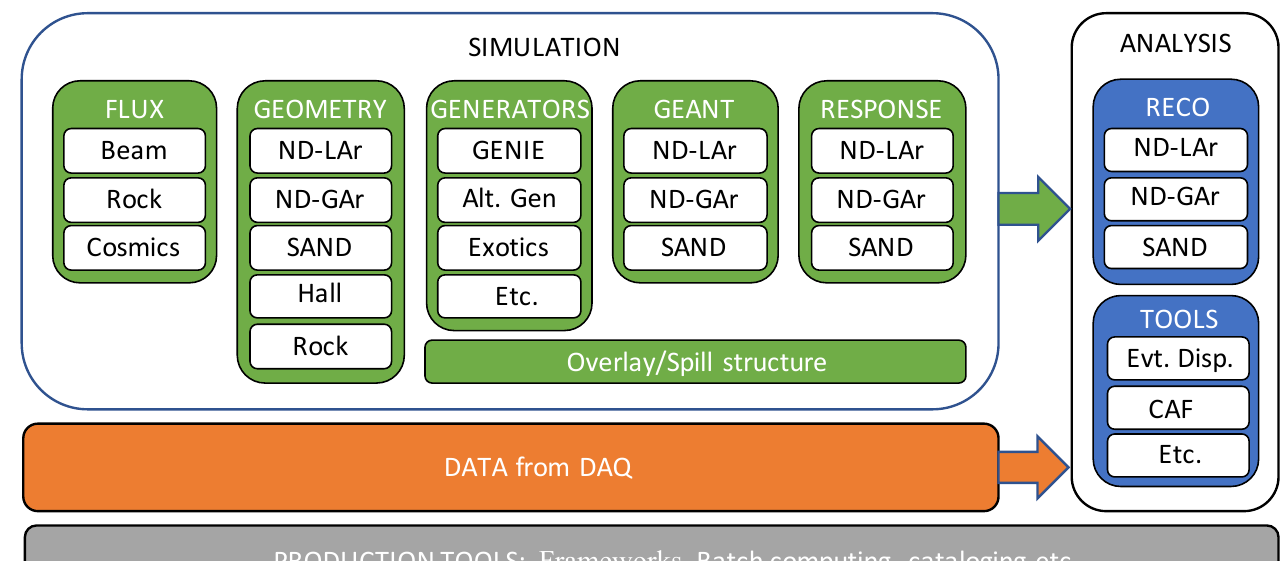
Figure 185. Overview of DUNE ND